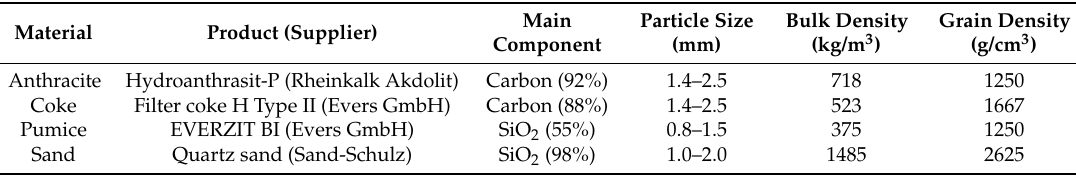
Table 1. Physical characteristics of the filter